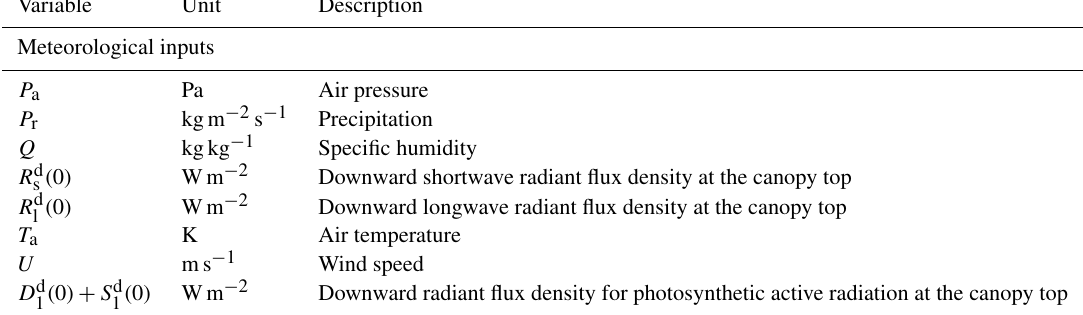
Table 4. Observational data used for validation at the parameterization site. Variable